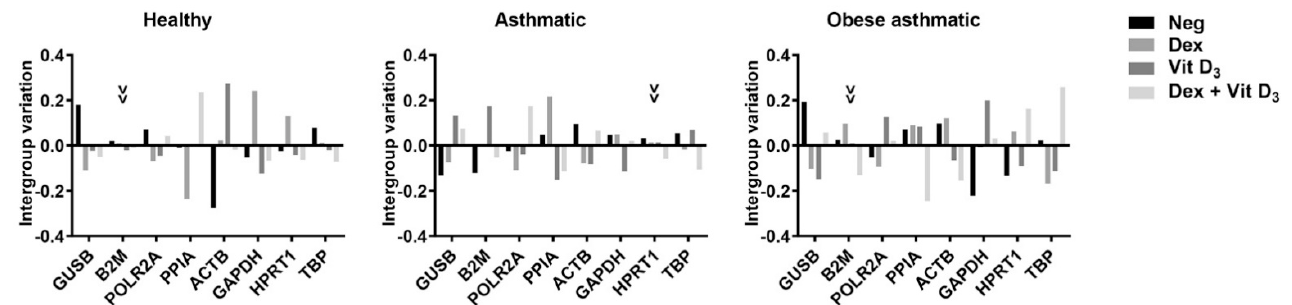
Figure 1. Intergroup variations in PBMCs from healthy subjects, asthmatic subjects, and obese asthmatic subjects. Arrowheads point to the most stable gene with the least intergroup variation.